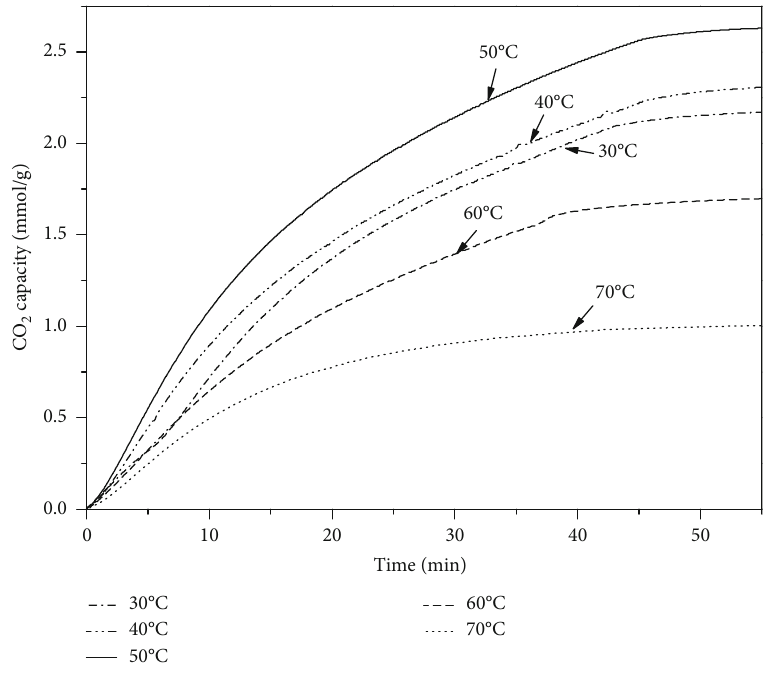
Figure 6: CO capacity of CPEI-3 at di ff erent temperatures at 2